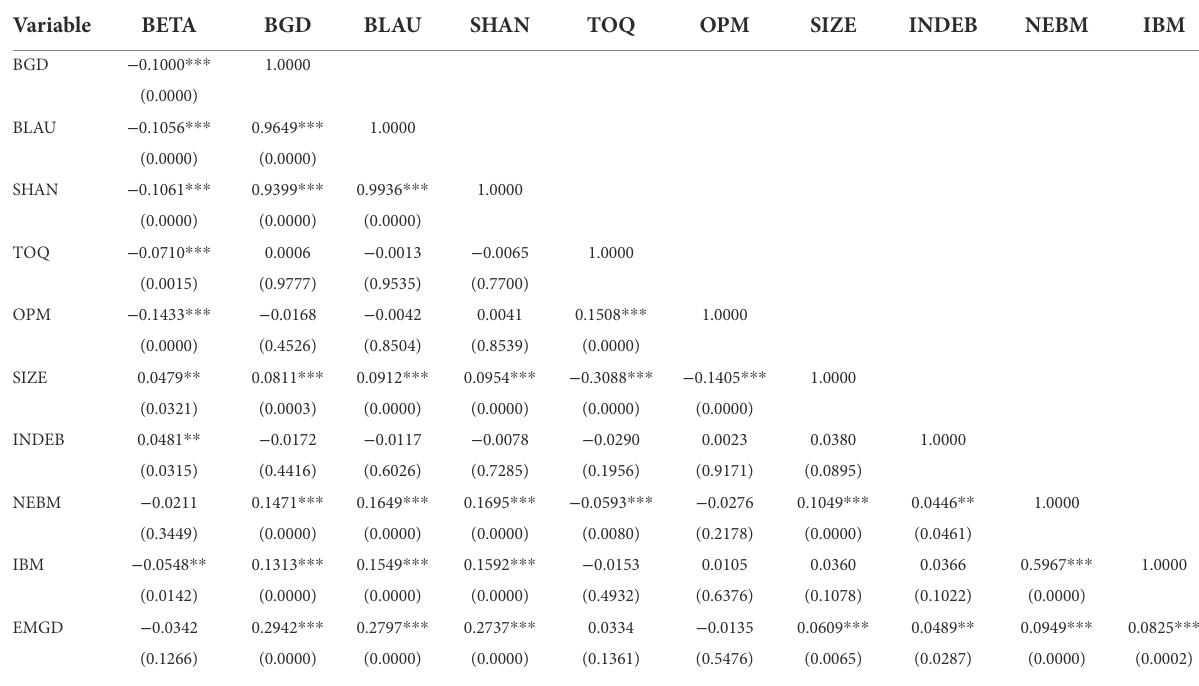
TABLE 5 Pearson correlations between continuous variables in the U.S.